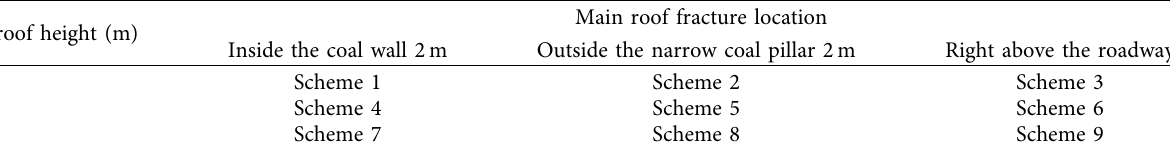
Table 4: Simulation scheme.